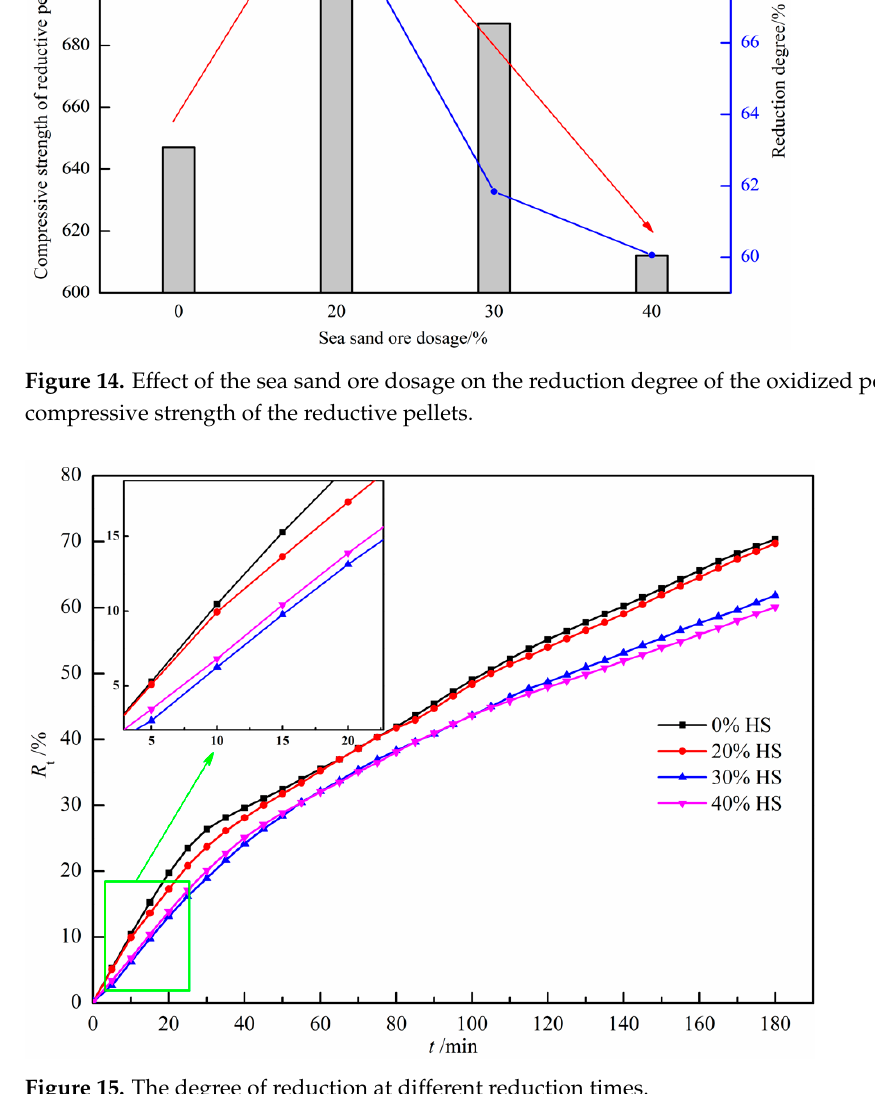
Figure 15. The degree of reduction at different reduction times.